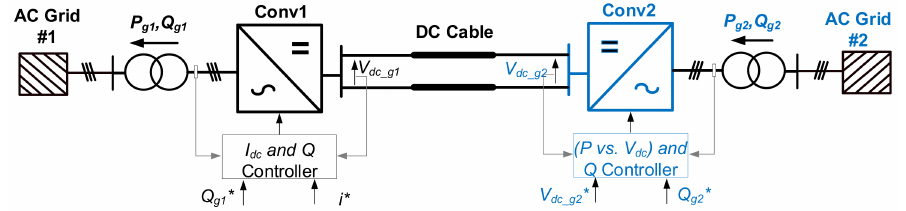
Figure 12. Two-terminal DC system with P vs. V dc droop and I dc control.